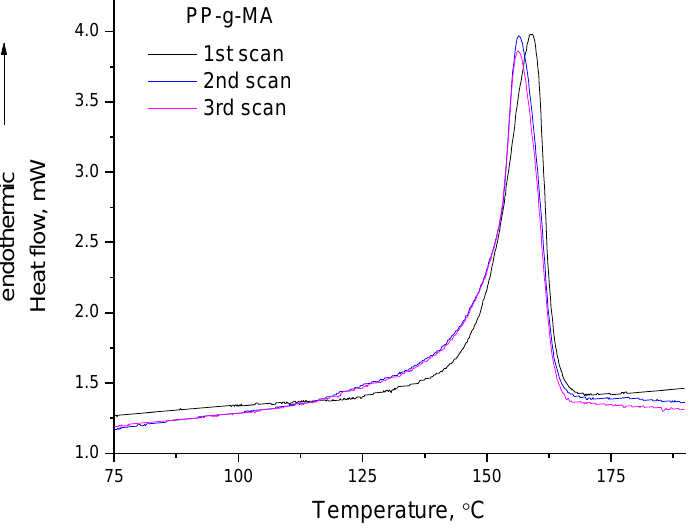
Figure 3. Three consecutive DSC scans of PP-g-MA.